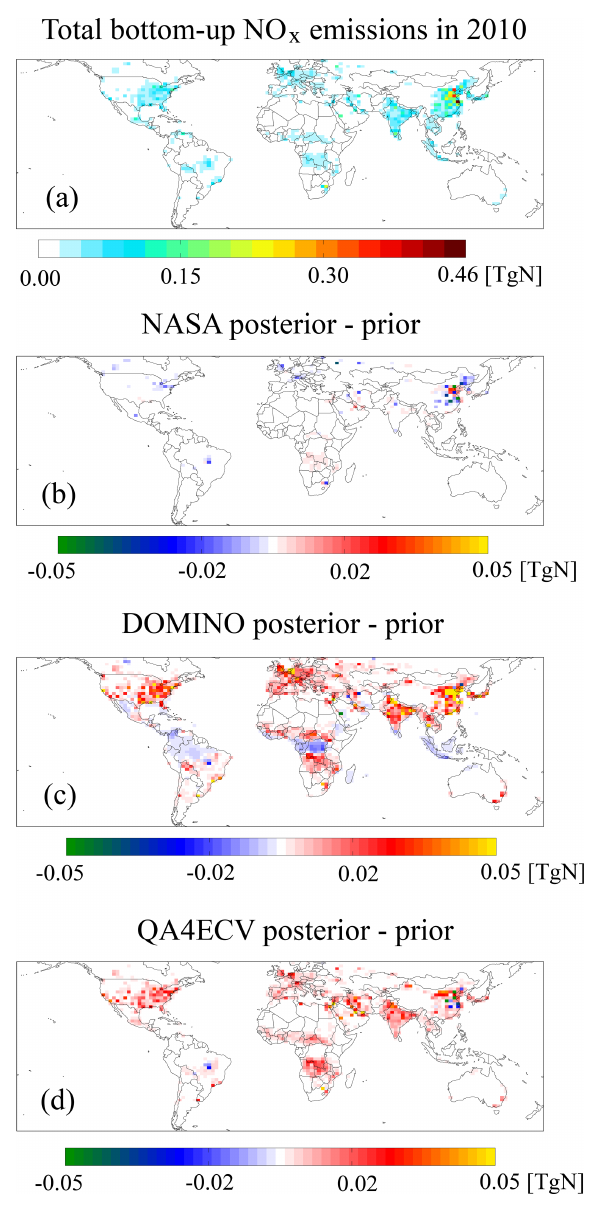
Figure 1. (a) Global total NO x emissions from the bottom- up inventory and the differences between 4D-Var posterior and bottom-up estimates constrained by (b) NASA standard product v3, (c) DOMINO product v2, and (d) QA4ECV product in